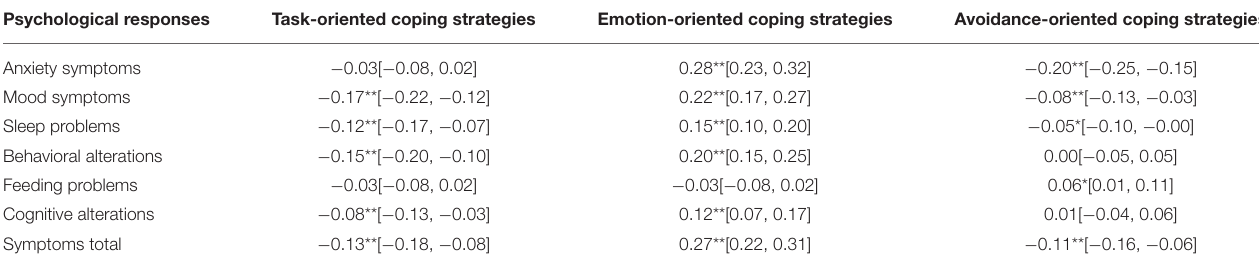
TABLE 4 | Correlations with confidence intervals for coping strategies and child’s immediate psychological